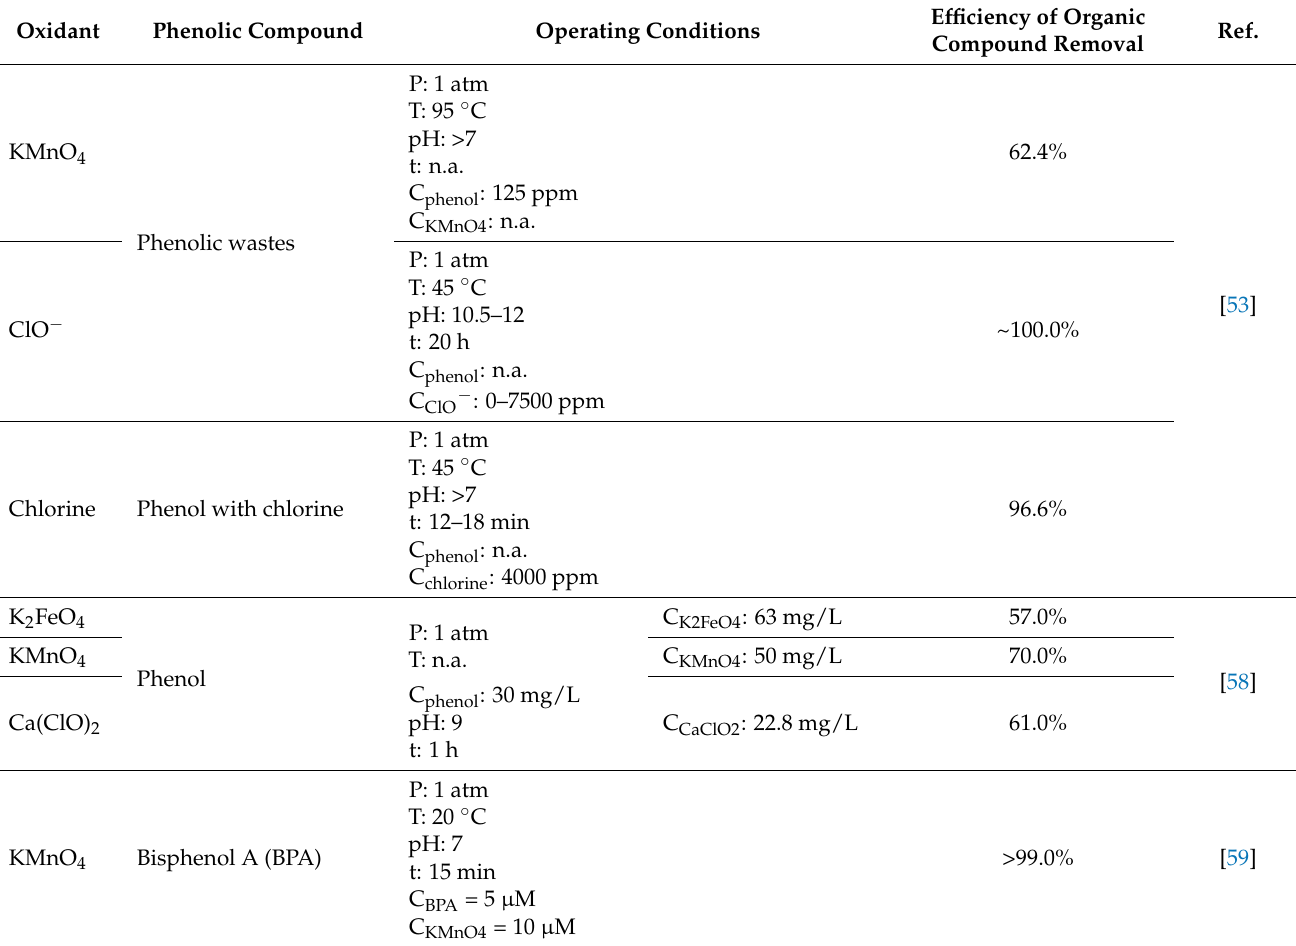
Table 6. Effectiveness comparison of various oxidants for phenol-based removal via chemical oxidation process in the aqueous phase. Oxidant Phenolic Compound